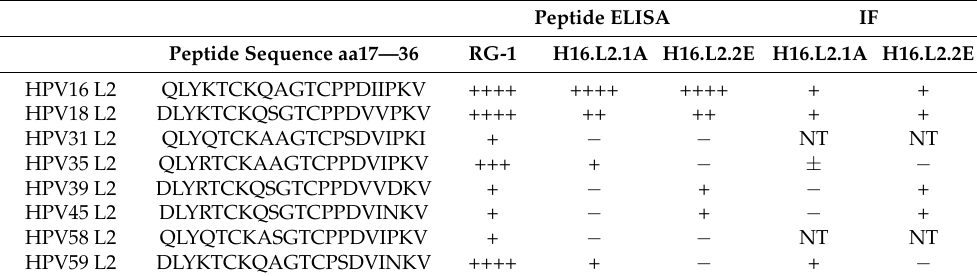
Table 1. Summaryof the results from the peptide ELISA and immunofluorescence (IF) assay. Peptide ELISA IF